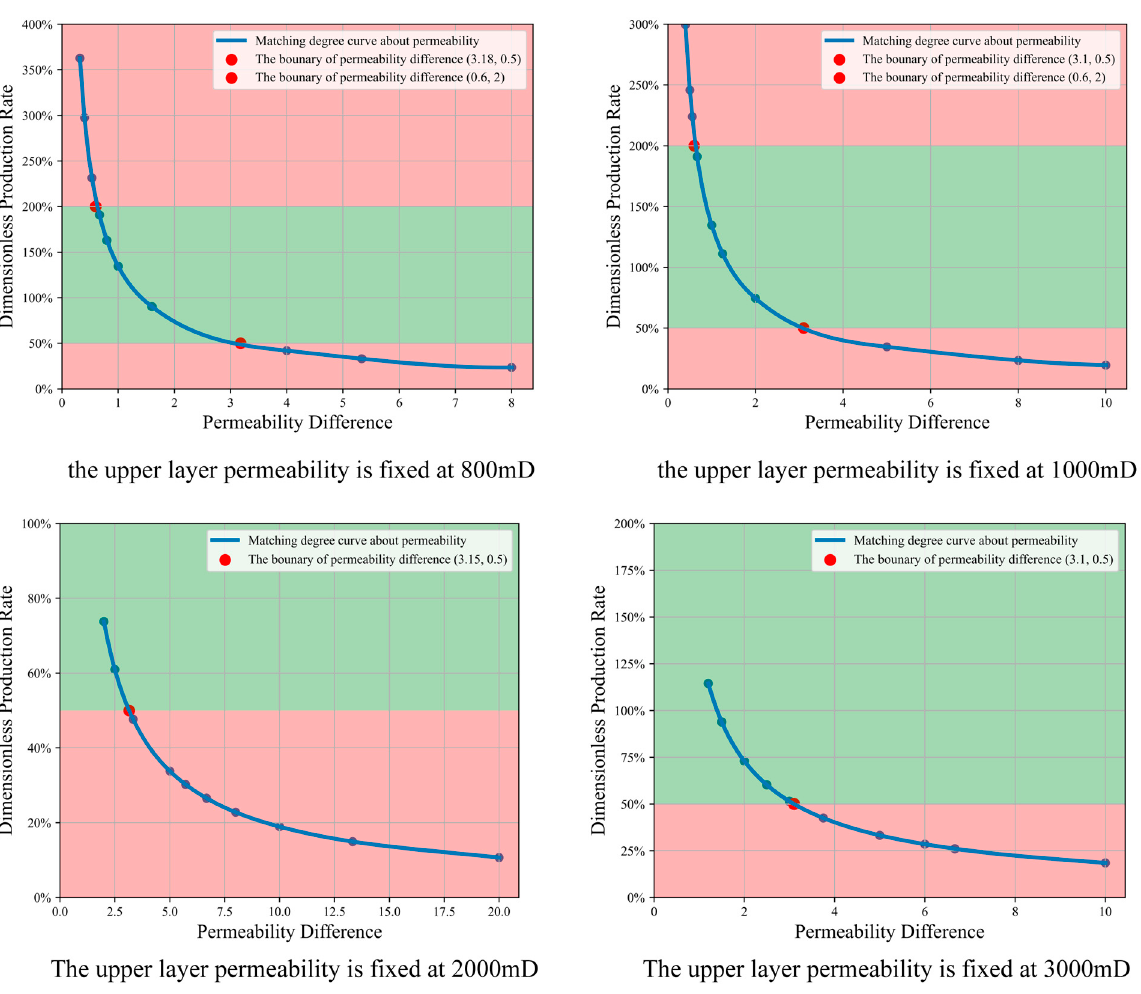
Figure 16. Matching degree curve for permeability difference when we change lower layer permea- bility.